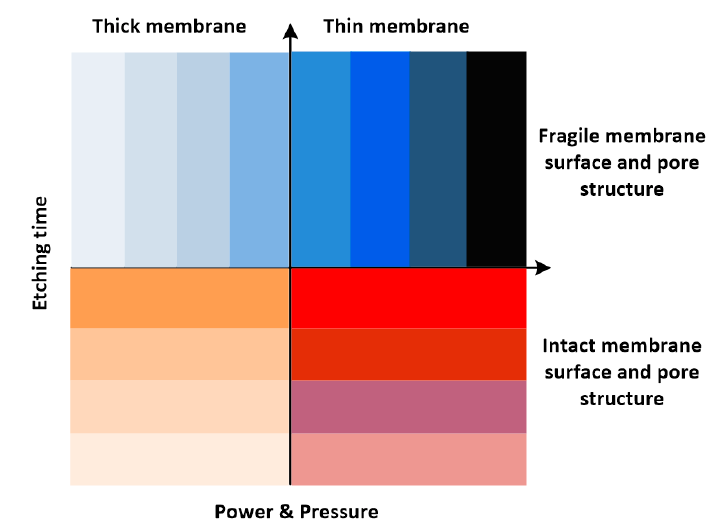
Figure 19. Schematic representation of the different parameters controlling the PDMS membrane morphology via PS µ M.